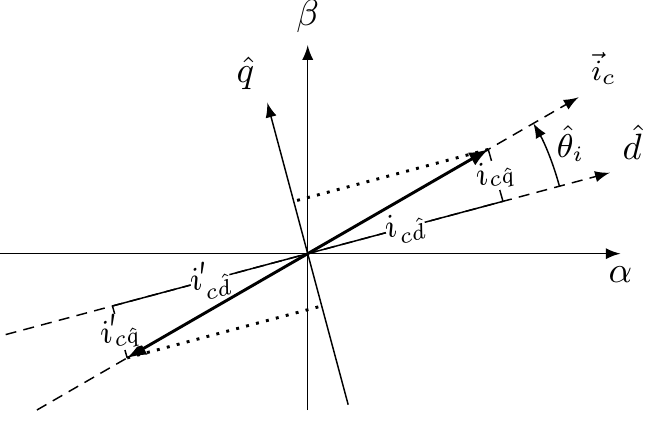
Figure 6. The oscillating current vector (cid:126) i c in the estimated